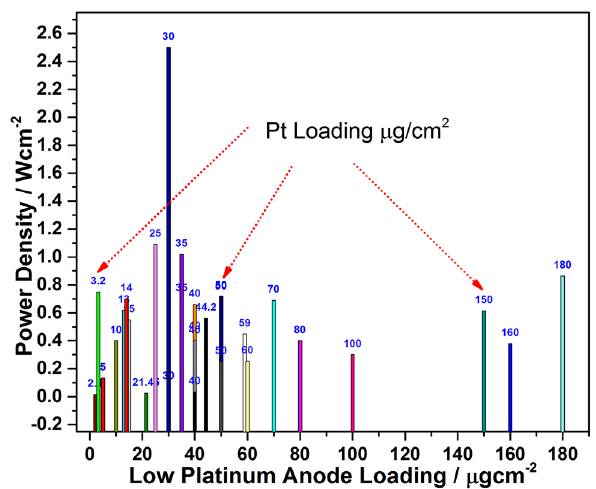
Fig. 3 Fuel cell performances with different anode catalyst loading, and comparison with literature values (as per data in Table 3)